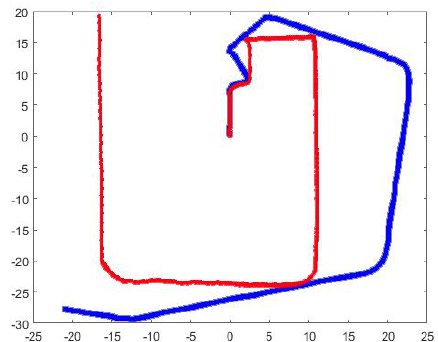
Figure 6. Trajectory results produced by Layout SLAM (unit meter) with no loop closing (red), and Mono SLAM (blue).